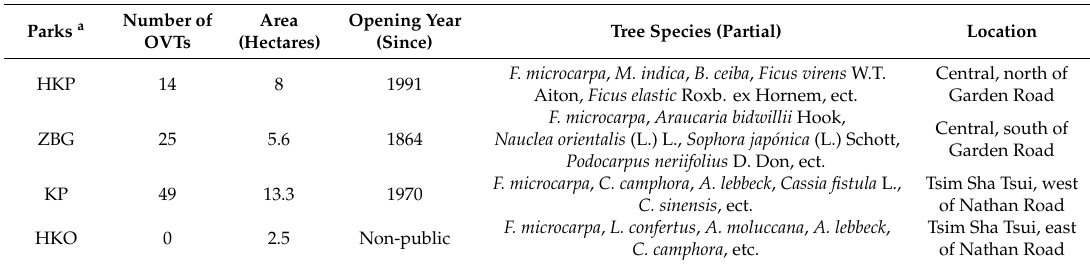
Table 1. Number of Old and Valuable Trees (OVTs), area, opening year, common tree species, and location of Hong Kong Park (HKP), Hong Kong Zoological and Botanical Garden (ZBG), Kowloon Park (KP), and Hong Kong Observatory Grounds